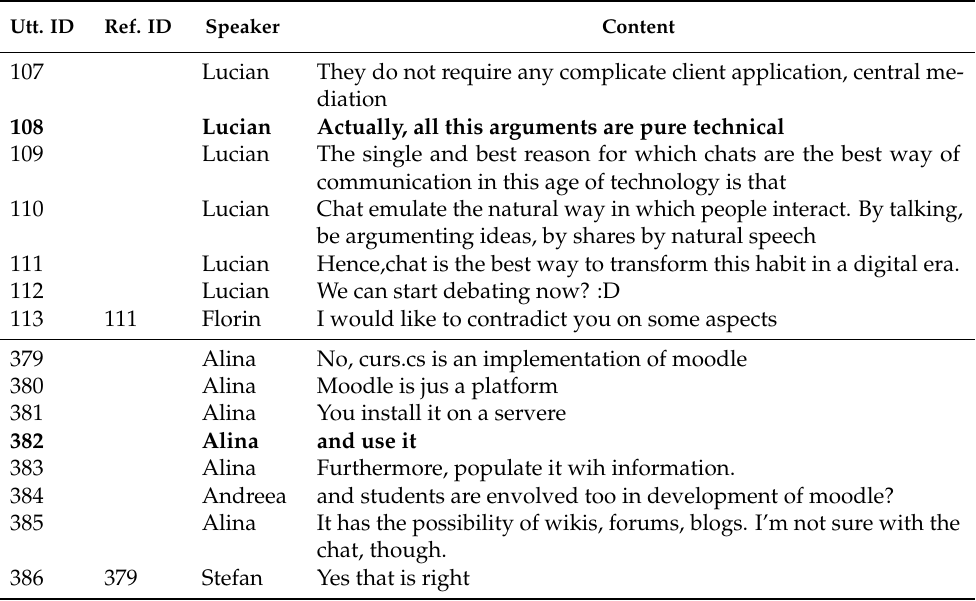
Table 2. Fragments extracted from conversations showing in-turn matching (Semantic link is high- lighted in